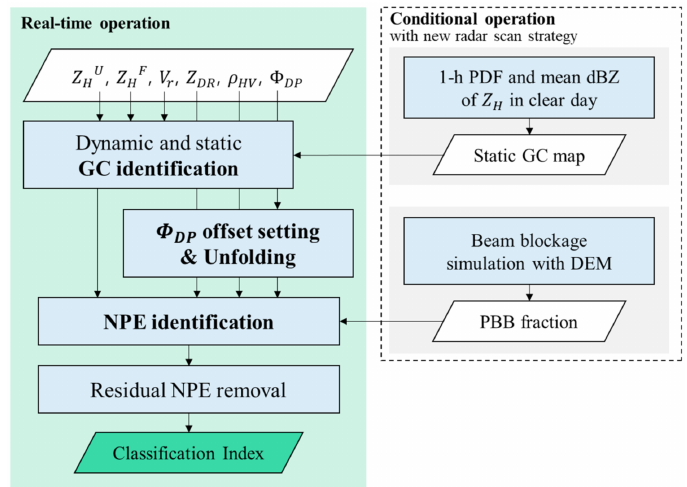
Figure 2. Flowchart of clutter elimination algorithm for non-precipitation echo of radar data (CLEANER) with the four main processes and two